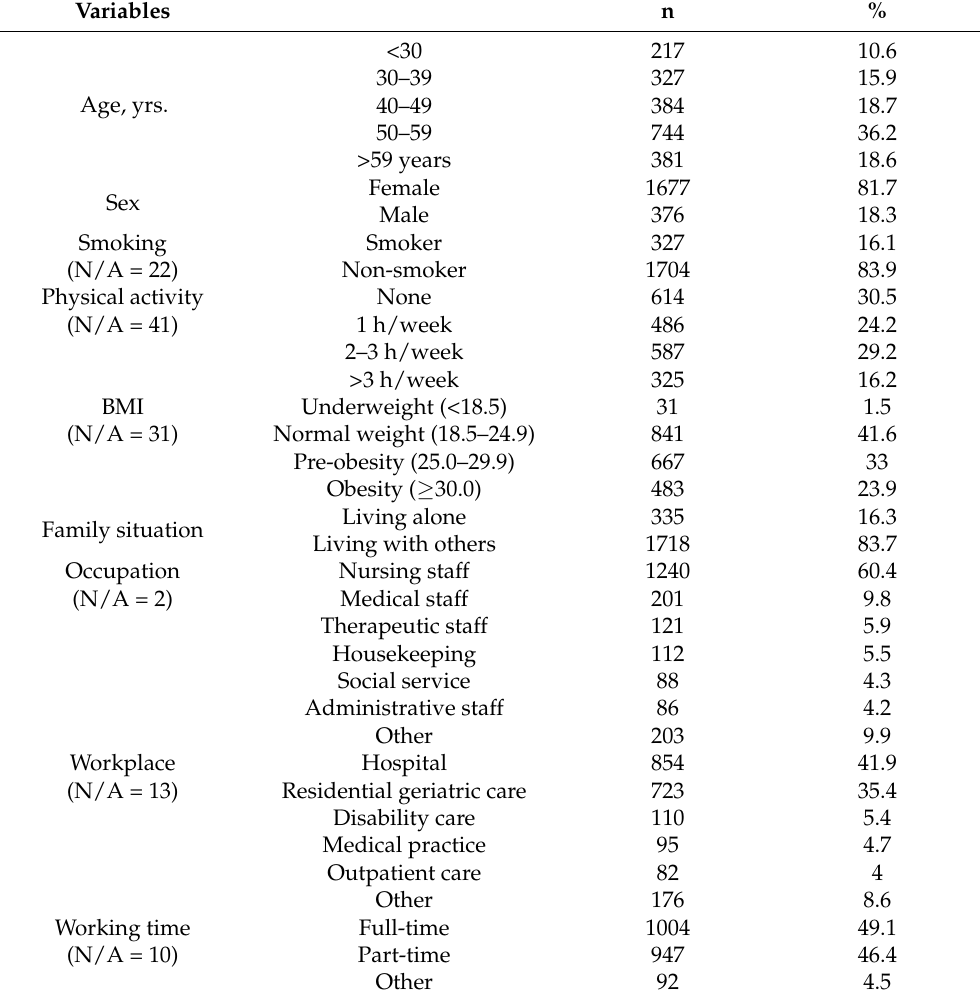
Table 1. Characteristics of the study population (n =